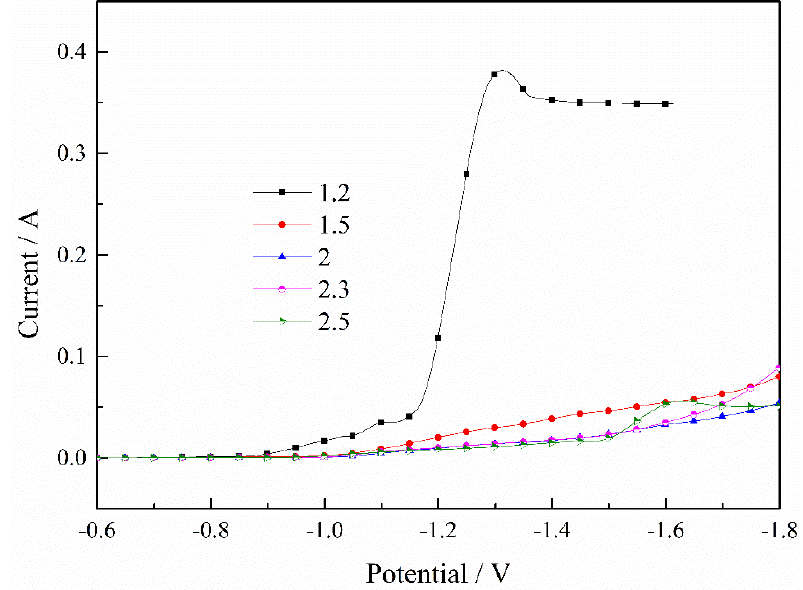
Figure 1. Effect of pH value on the deposition of Fe 2+ . T = 30 °C .